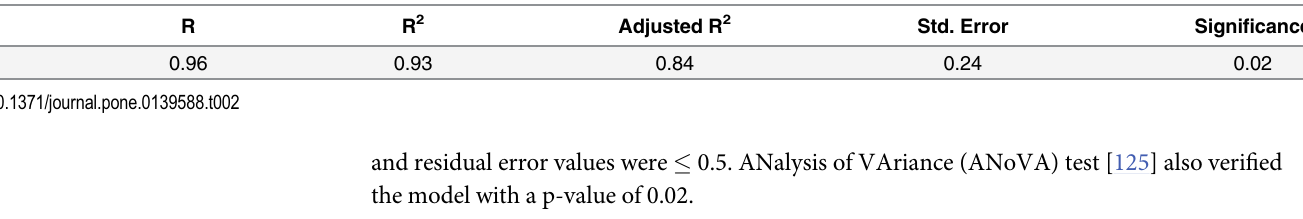
Table 2. Statistical parameters for regression model.